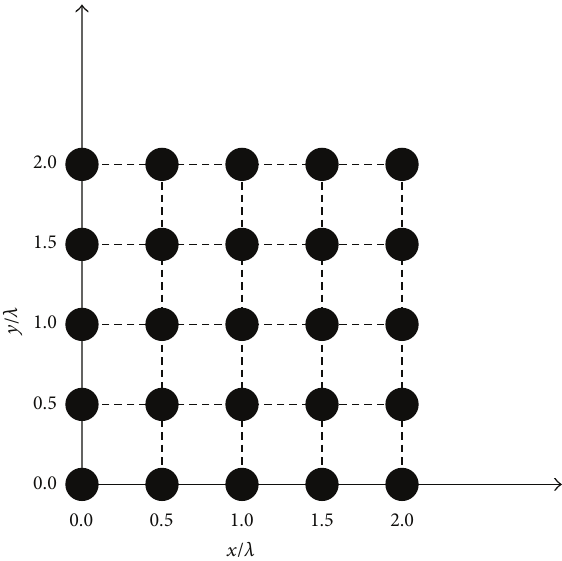
Figure 2: Geometry of the receiving fully populated array ( 𝑁 = 25 ).